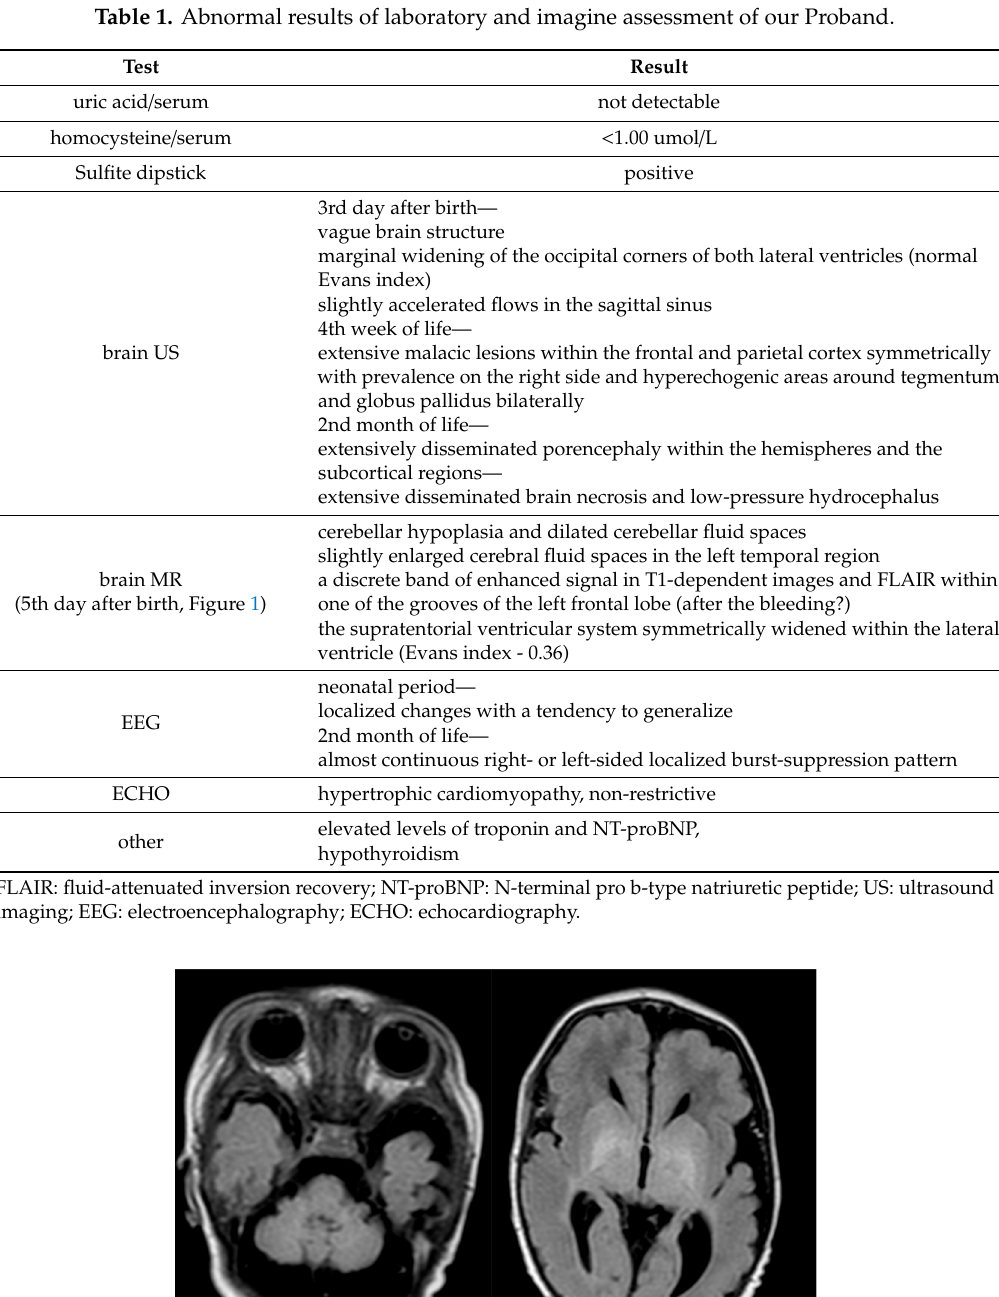
Table 1. Abnormal results of laboratory and imagine assessment of our Proband.